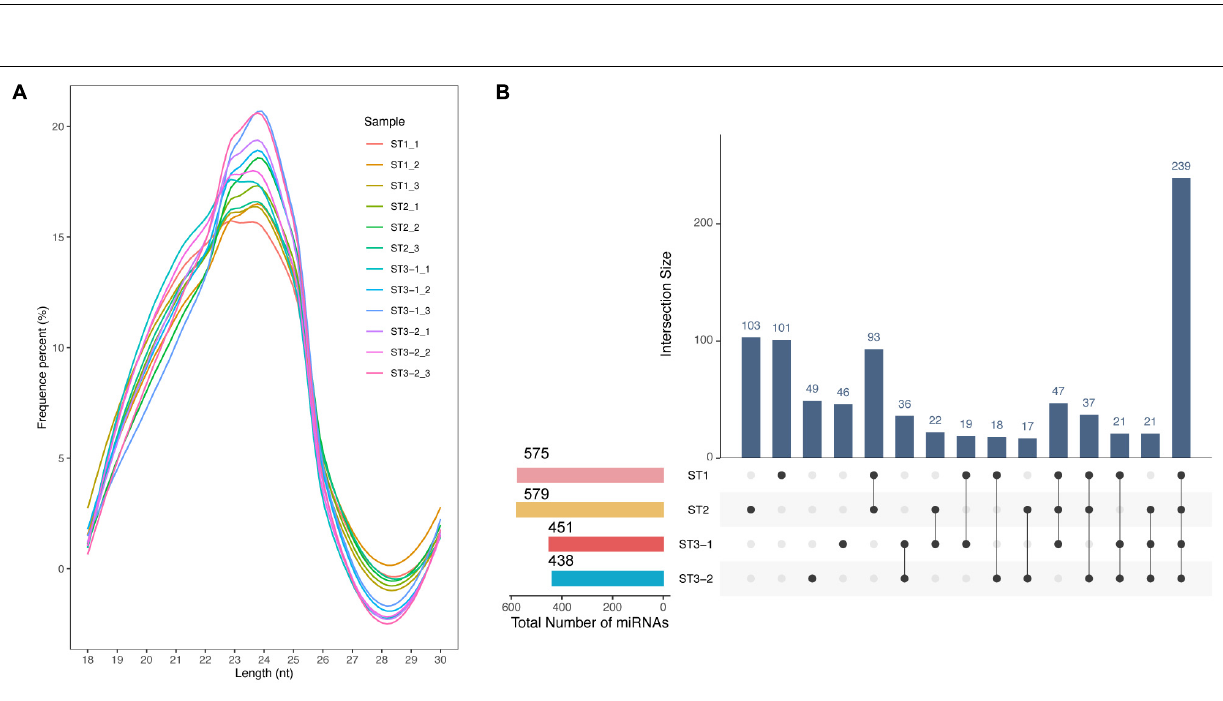
FIGURE 5 | Characteristics of microRNAs (miRNAs) during the early differentiation of female strobilus buds in ginkgo. (A) Length distribution of the mappable sRNA reads from 12 libraries. (B) The UpsetR plot shows the number of miRNAs identified from each stage, i.e., the vegetative (ST1), the initial differentiation (ST2), and the exuberant differentiation stages (ST3-1 and